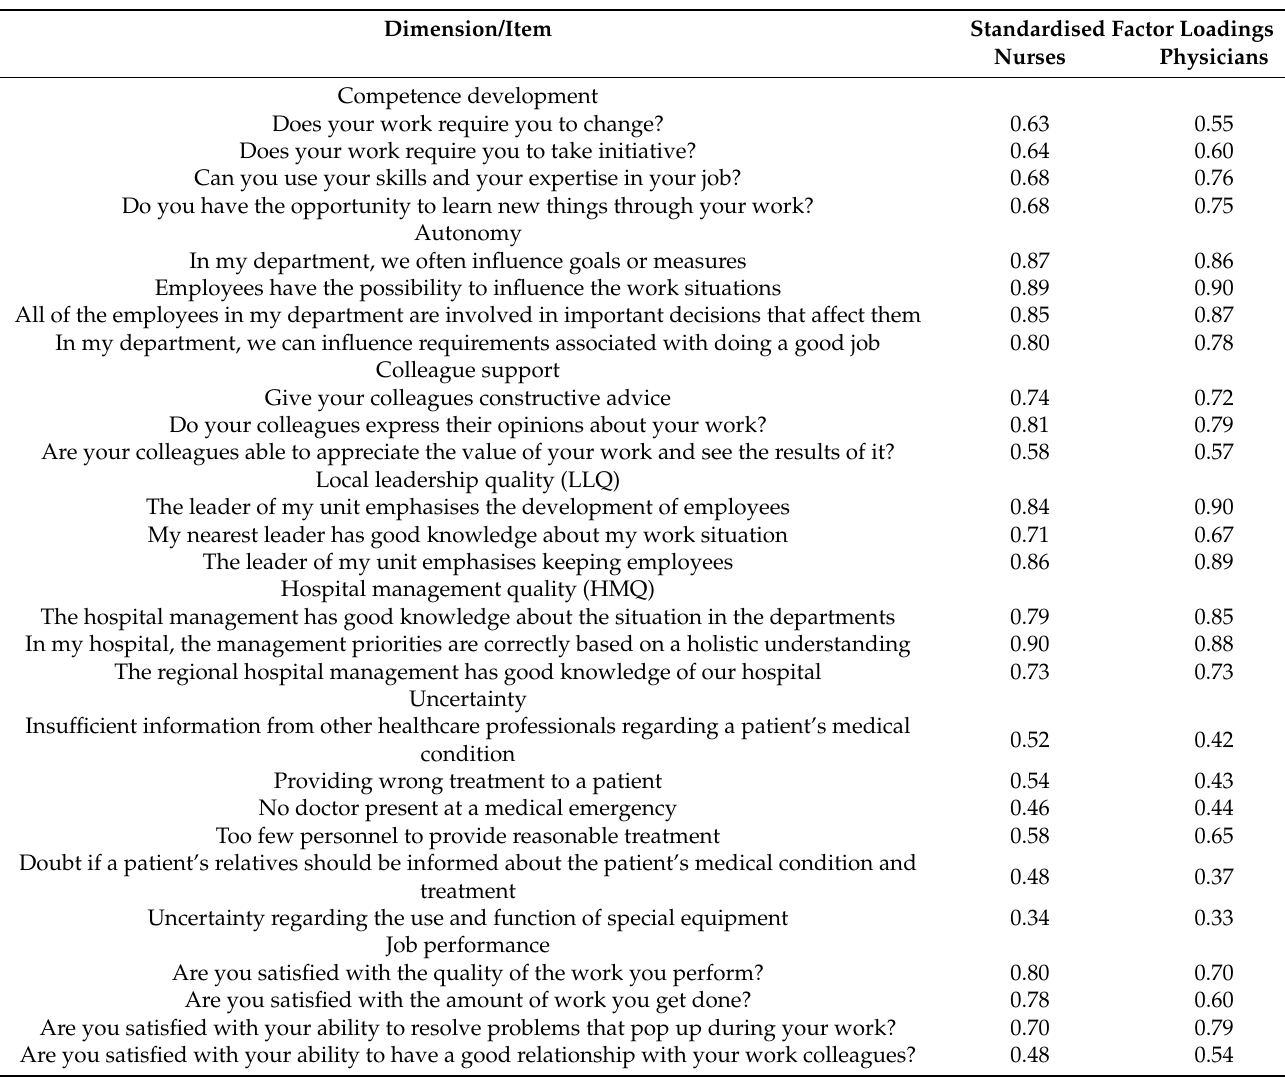
Table 4. Standardised factor loadings based on confirmatory factor analyses